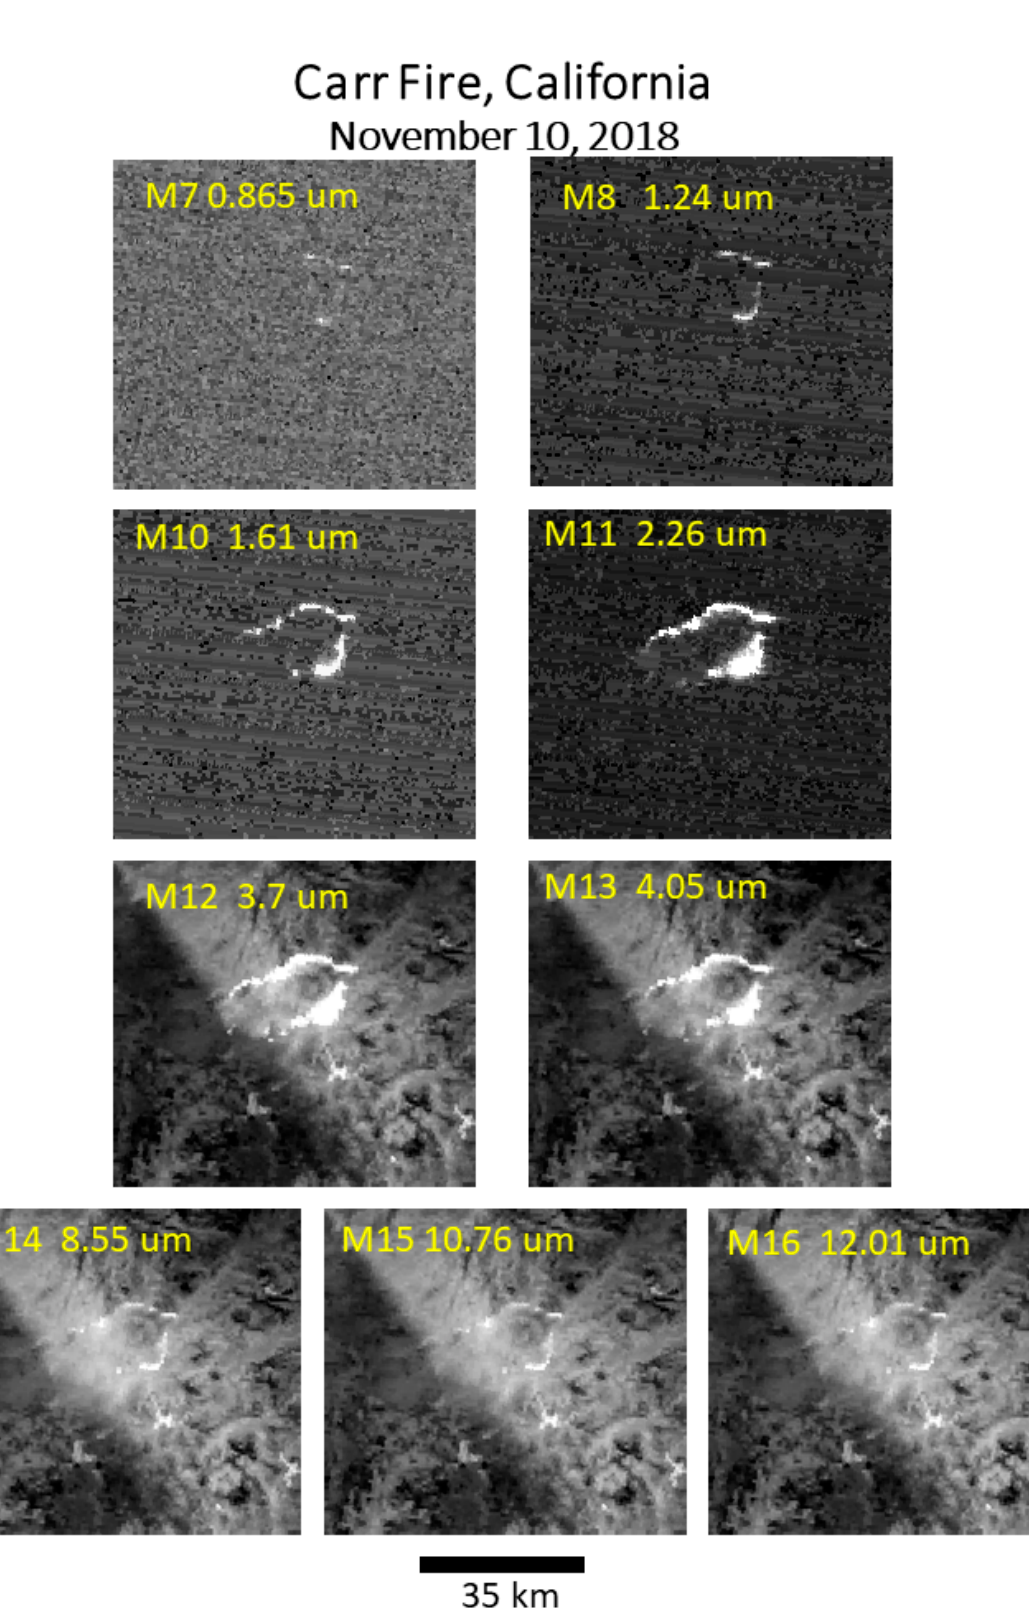
Figure 6. The Carr Fire study area.